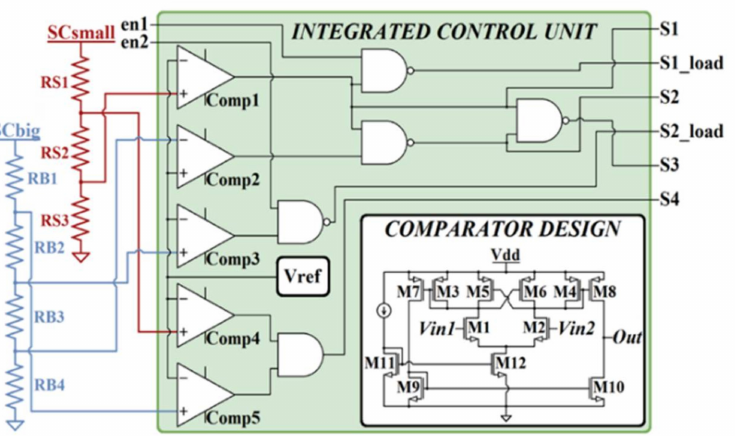
Figure 4. Control logic and comparator